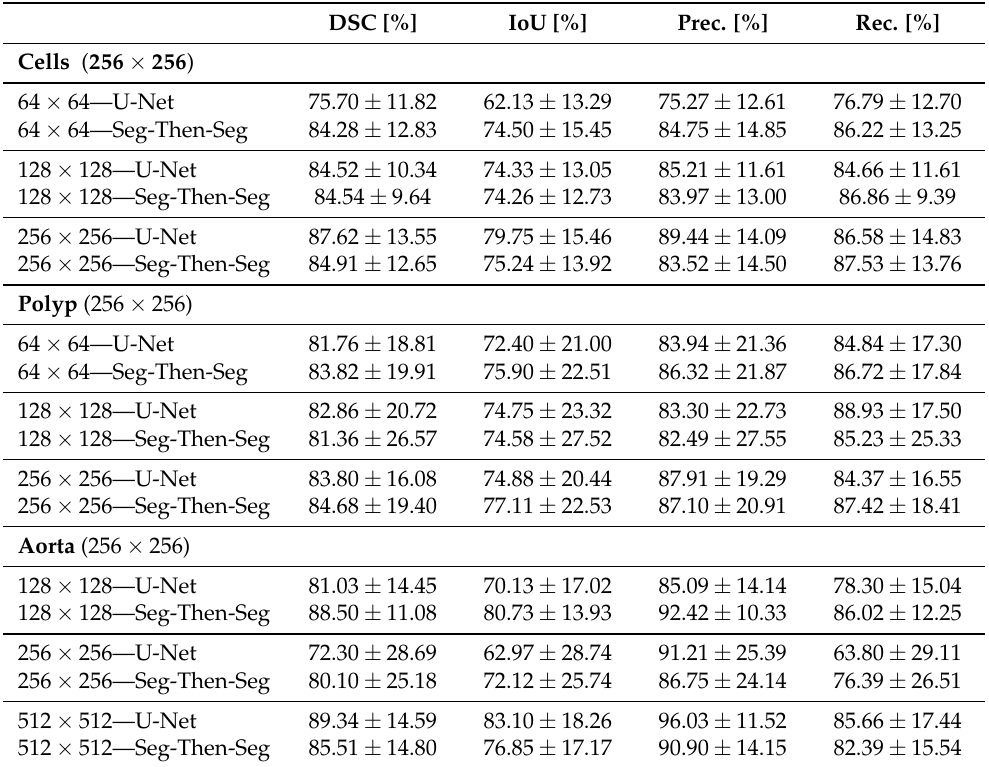
Table 2. The results of our approach U-Net as the underlying architecture. The complete results of all of our experiments are available in Appendix